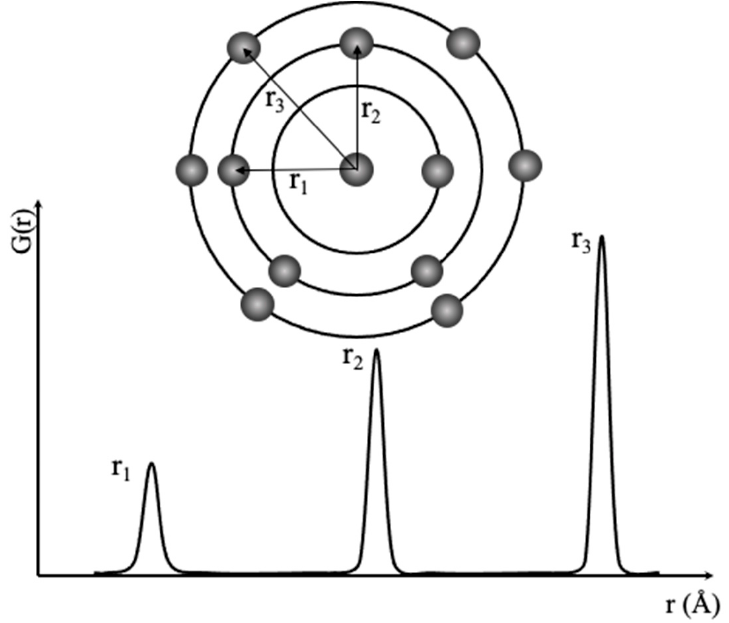
Figure 11. Schematics showing pair-wise distribution function for estimating the severe lattice distortions in CCAs.